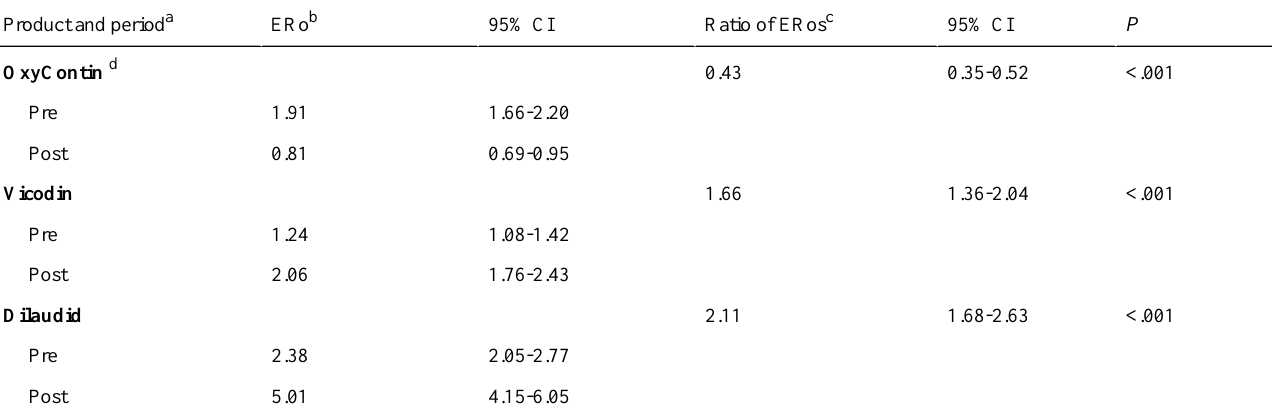
Table 3. Endorsement ratios (ERo) and post-to-preintroduction period ratios of